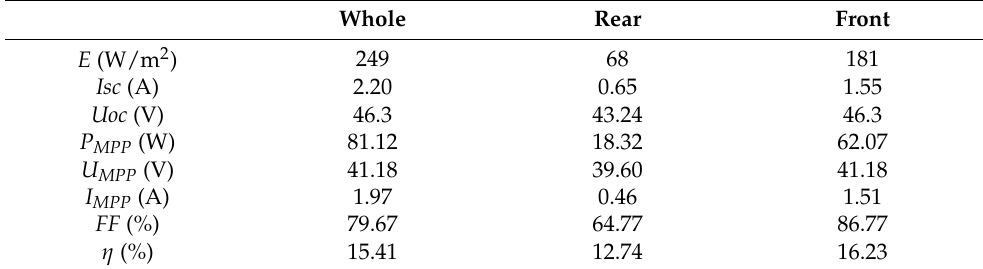
Table 12. The measurement results and calculations for 75 ◦ inclination of the module over the white substrate, considering the values for the whole-module generation and its rear side generation. Whole